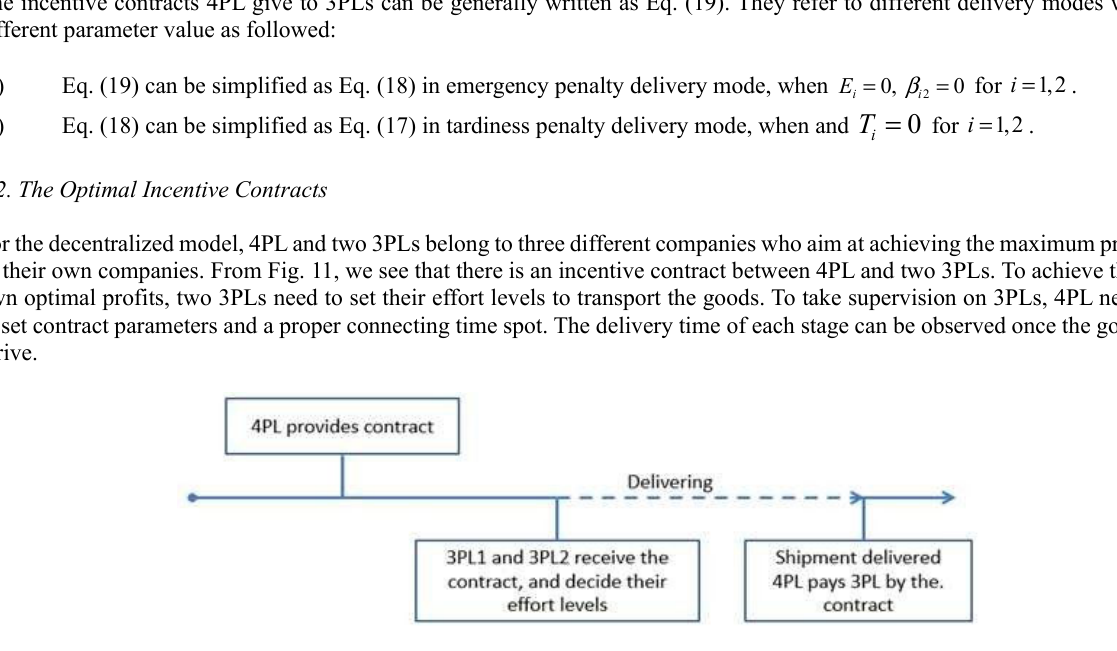
Fig. 11. Sequence of events in the decentralized